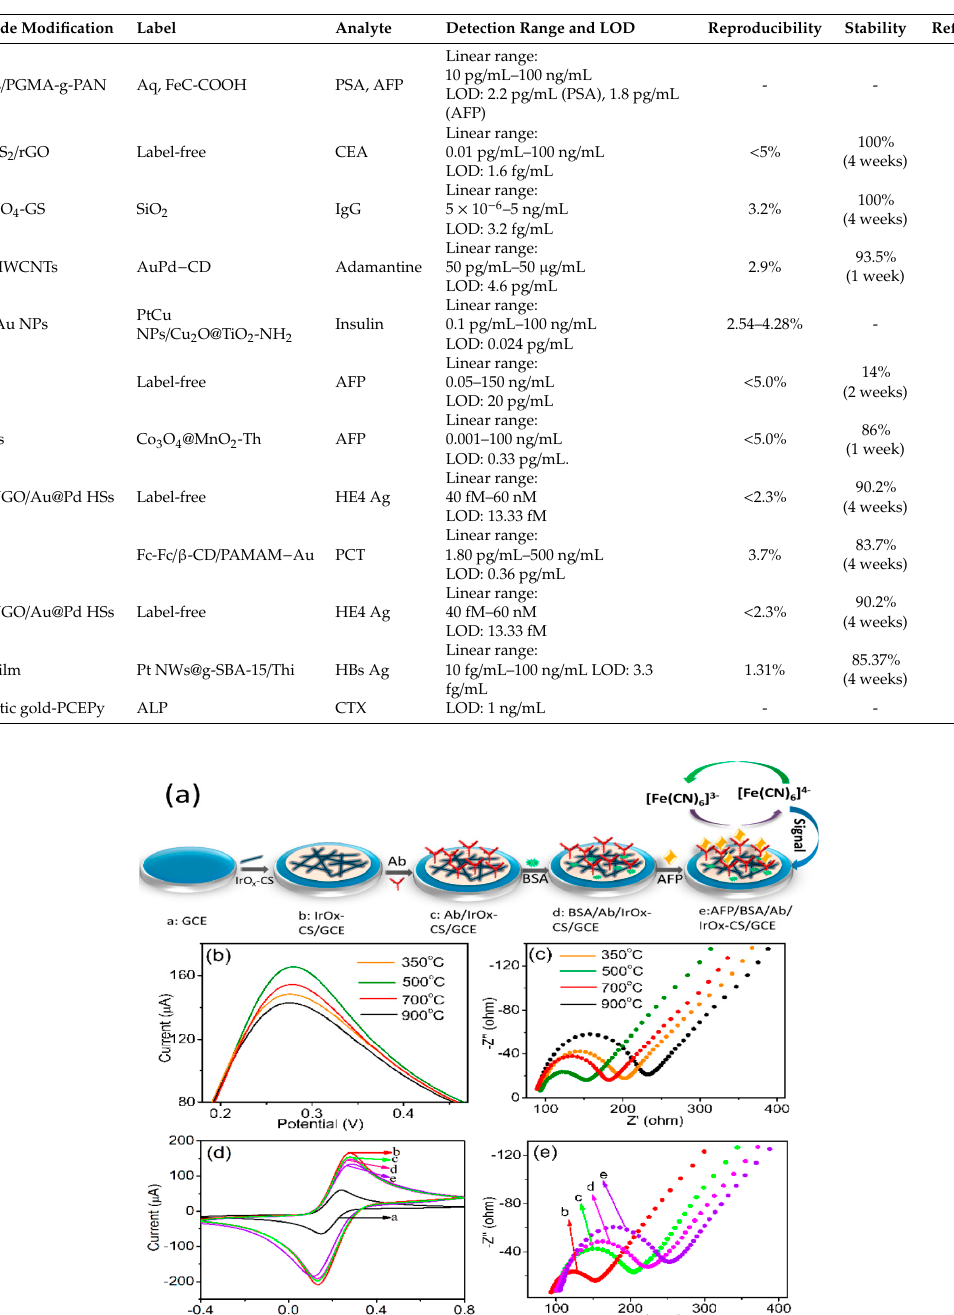
Table 2. Metal Nanomaterials for electrochemical immunosensors.